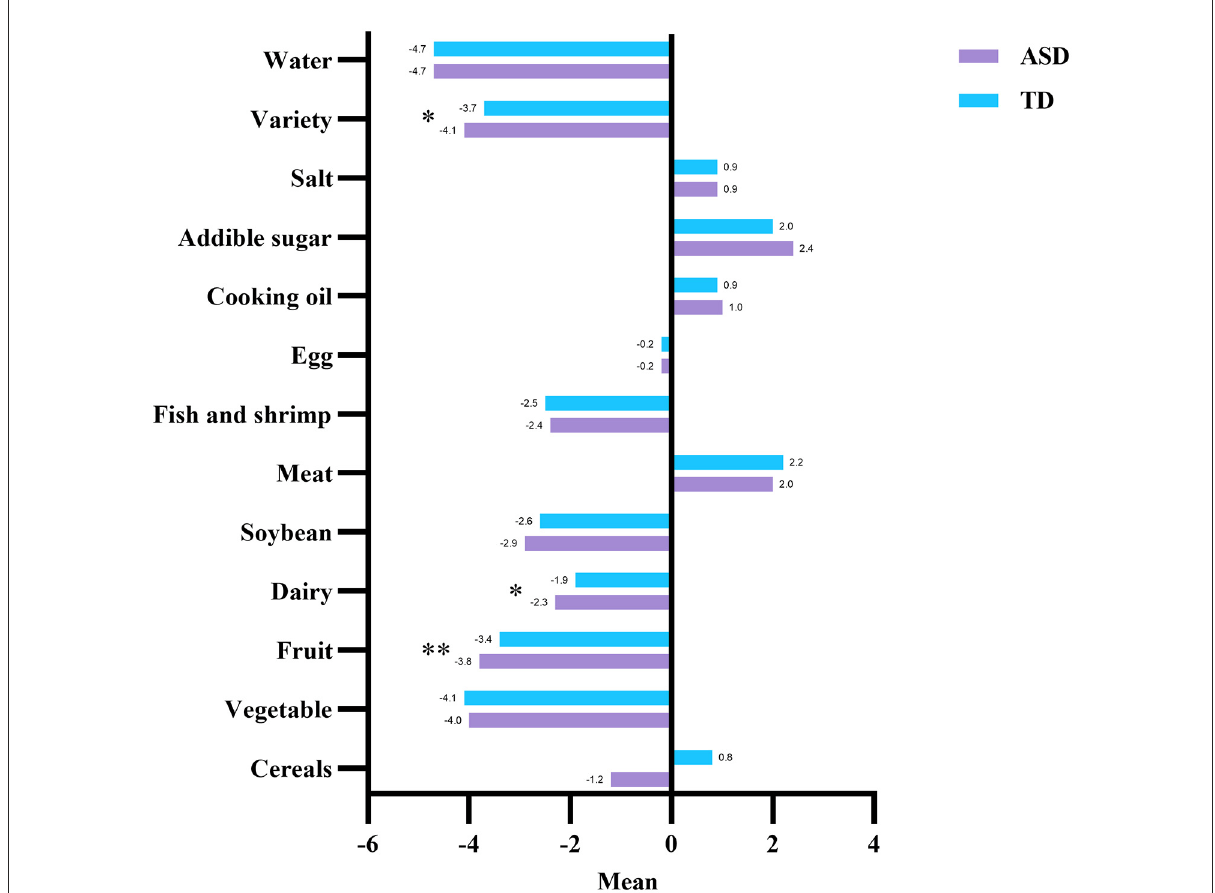
FIGURE2 Comparison of DBI_16 components among children with ASD and TD children. ASD, autism spectrum disorder; TD, typically developing; LBS, Low Bound Score; HBS, High Bound Score; DQD, Diet Quality Distance. * P < 0.05; ** P <